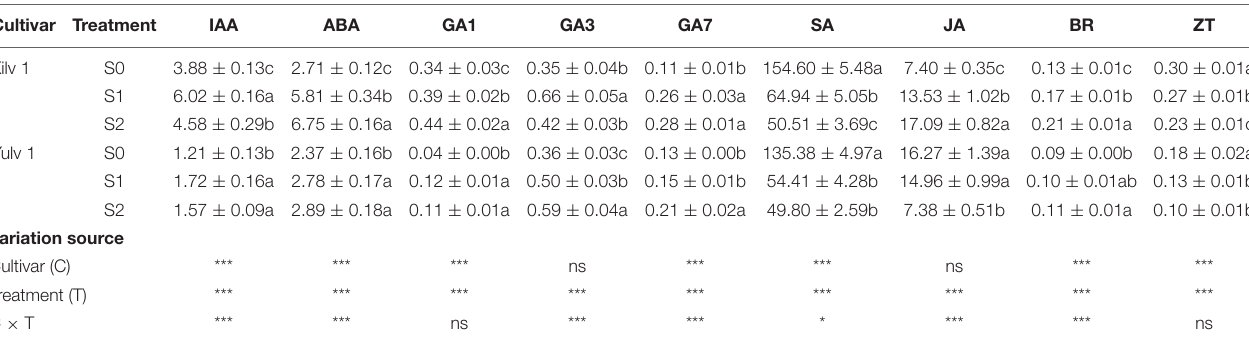
TABLE 2 | Effect of shading stress on the leaf hormone concentrations (ng g − 1 , FM) in mung bean. Cultivar